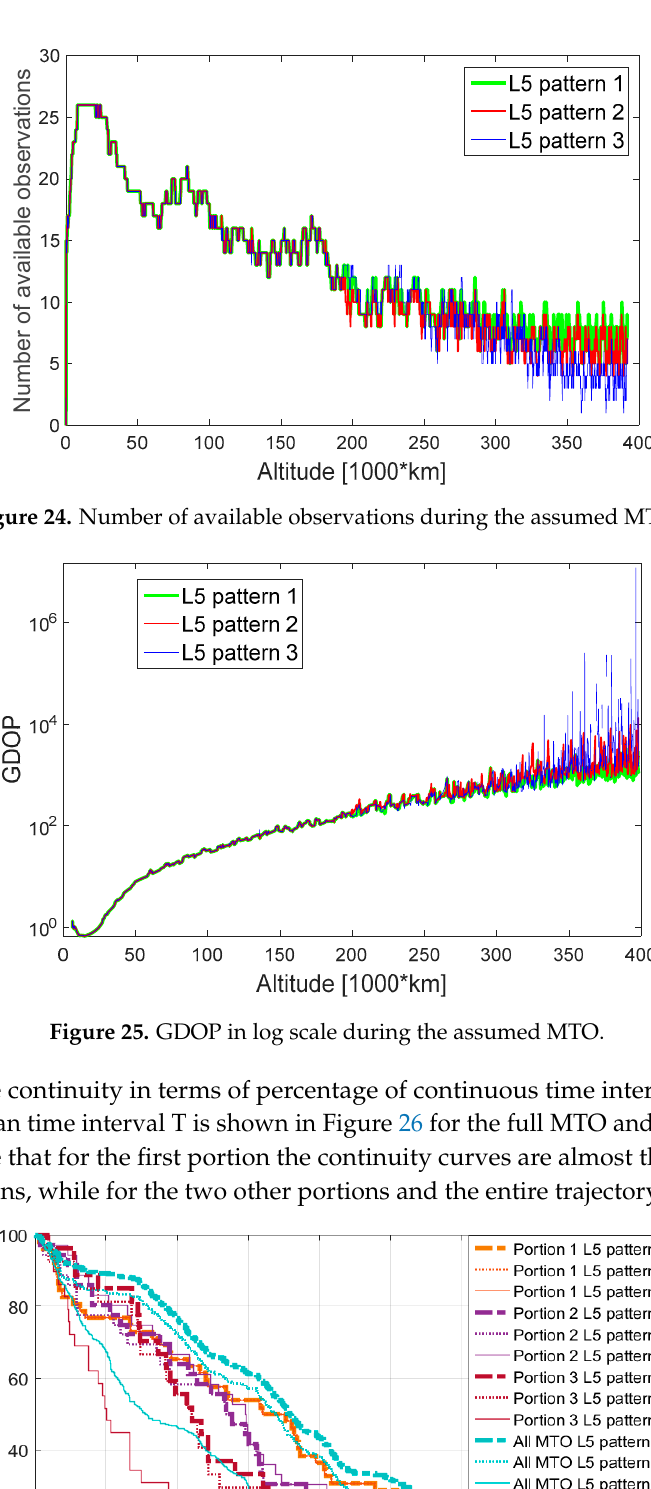
Figure 26. Percentage of continuous time intervals, a point of each curve identifies a time interval duration T (on the x -axis) and the corresponding percentage (on the y -axis) of continuous time intervals equal or longer than T.